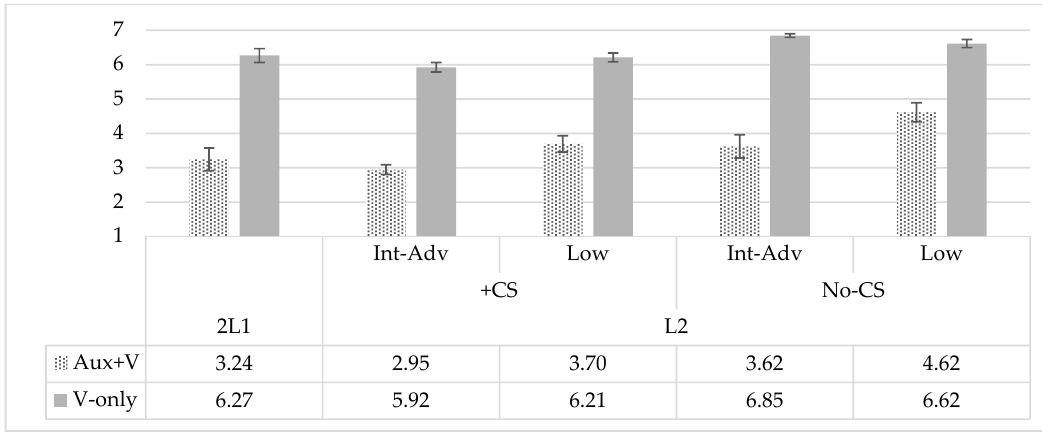
Figure 6. Monolingual English subject stimuli ratings by group and type. DP: determiner phrase. The combined code-switched subject stimuli are presented in Figure 8, with the results separated by switch direction (i.e., English-to-Spanish or Spanish-to-English) in Figures 9 and 10. As was the case with the verb stimuli, we see a clear distinction between the code-switched subject stimuli and their monolingual comparisons. Although the control lexical DP stimuli received favorable scores at the high end of the acceptability scale, the weak pronoun stimuli ratings are reduced and more variable, including some scores averaging toward the middle of the scale. Even more interesting, though, is that the weak pronoun stimuli ratings seem to vary more substantially from group to group, with the 2L1 bilingual group rating them the lowest, and the L2 No-CS Low group rating them at almost the same level as the lexical DP stimuli. Again, there is some minor variability when comparing the switch direction, as the Spanish-to-English switches seem to be rated as slightly more acceptable across the board. Nonetheless, the overall trend remains the same: the less a bilingual uses